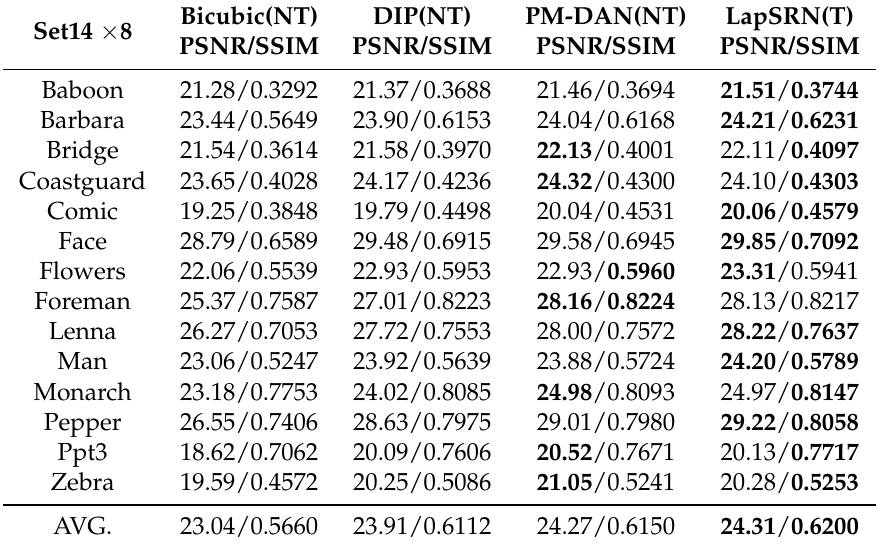
Table 6. 8 × SR comparison on Set14. The best PSNR and SSIM values are highlighted in bold. Set14 ×